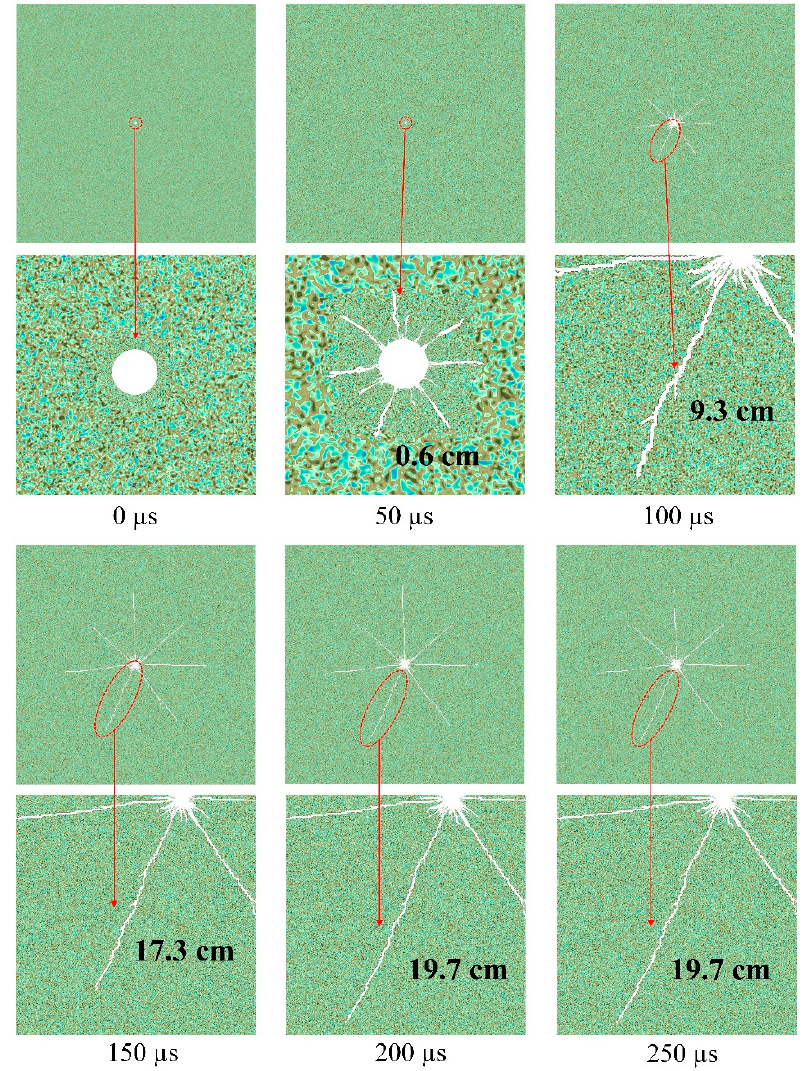
Figure 17. Granite failure process and development of cracks under high-voltage electropulse with time.